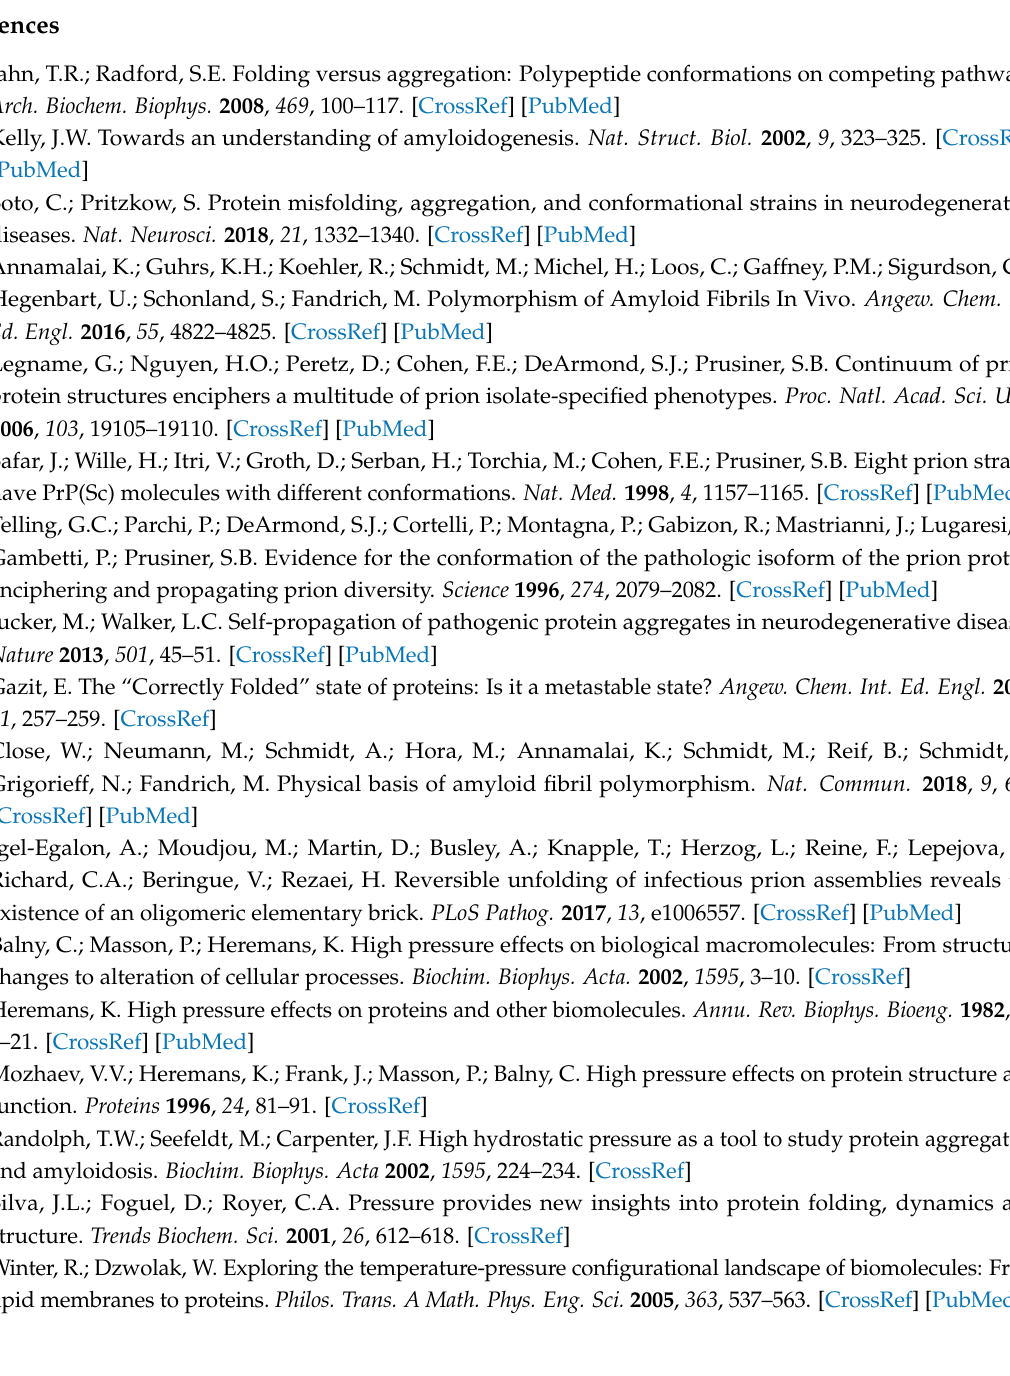
after removing fibrils by centrifugation, Figure S2: Fluorescence emission spectra of ThT (A) and ANS (B) in the absence of protein (black line), and in the presence of hamster (blue line) and ovine (red line) PrP fibrils. a.u., arbitrary